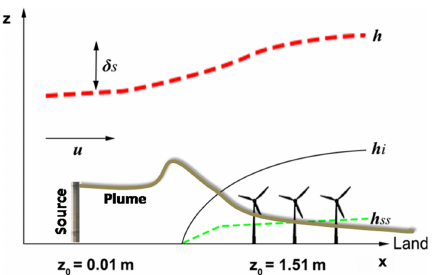
Figure 14. Schematic view of the IBL and an air pollutant pass- ing through a wind farm. The IBL and PBL change from smaller roughness length 0.01m to large roughness length 1.51m. The red dashed line h indicates the PBL thickness, black solid line h i in- dicates the IBL, the green dashed line h ss indicates a sublayer, u indicates the wind vector, and δ s indicates the upward displacement of PBL thickness change.